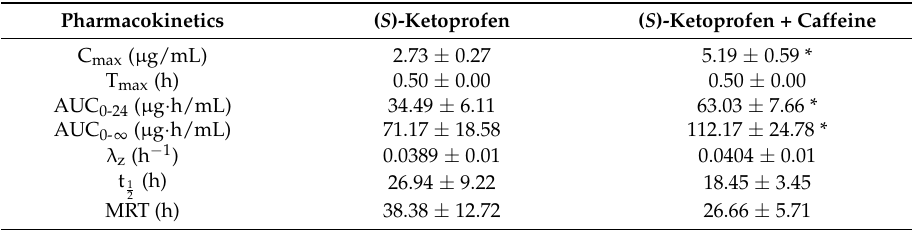
Table 1. ( S )-ketoprofen parameters. Mean ± SEM, n = 6. * p <